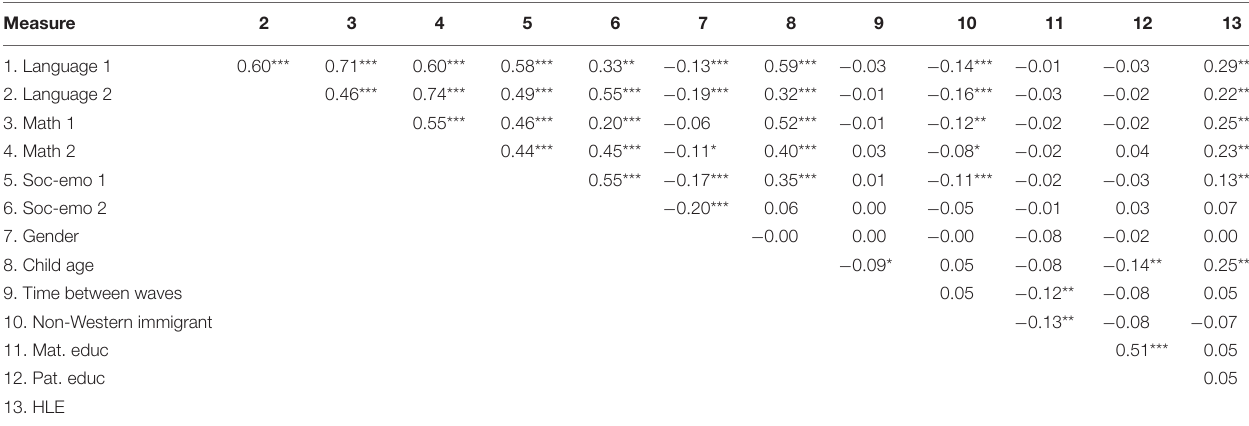
TABLE 2 | Correlations between the child measures and background